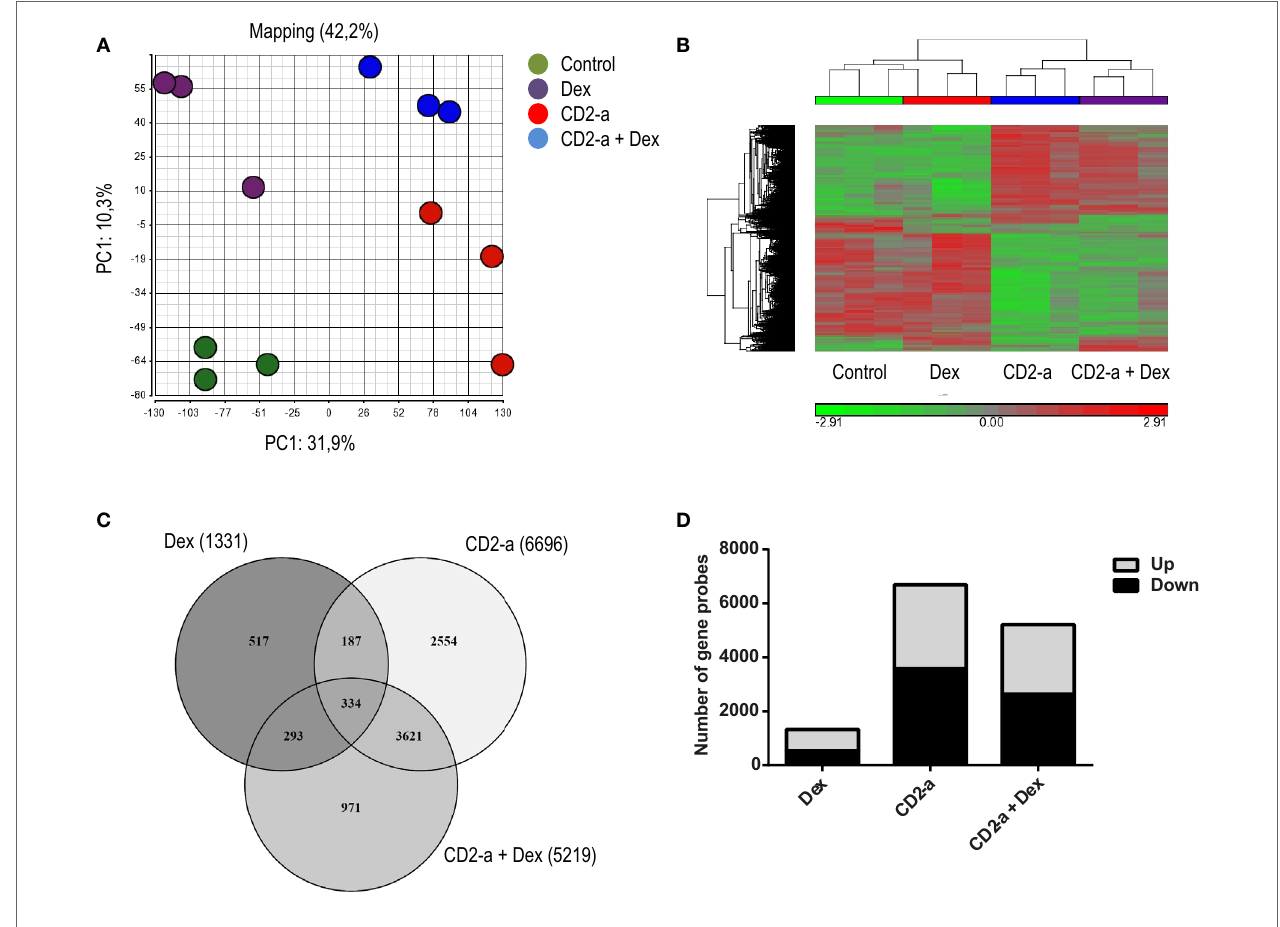
FigUre 1 | Dex and CD2-a Escherichia coli strains modulate gene expression in THP-1 macrophages. (a) Principal component analysis (PCA) from mRNA microarray performed on THP-1 macrophages. PCA shows the two main components, with CD2-a exerting more influence on variance as compared to Dex. (B) Cluster analysis of normalized samples. ANOVA ( p < 0.05) and a cutoff of 1.5-fold change were used to select probes with statistical significance. Hierarchical clustering was performed based on 8,477 selected gene probes. (c) Venn diagram of the overlap in significant gene probes regulated by infection and/or Dex treatment. (D) Number of gene probes either induced (up) or repressed (down) by each